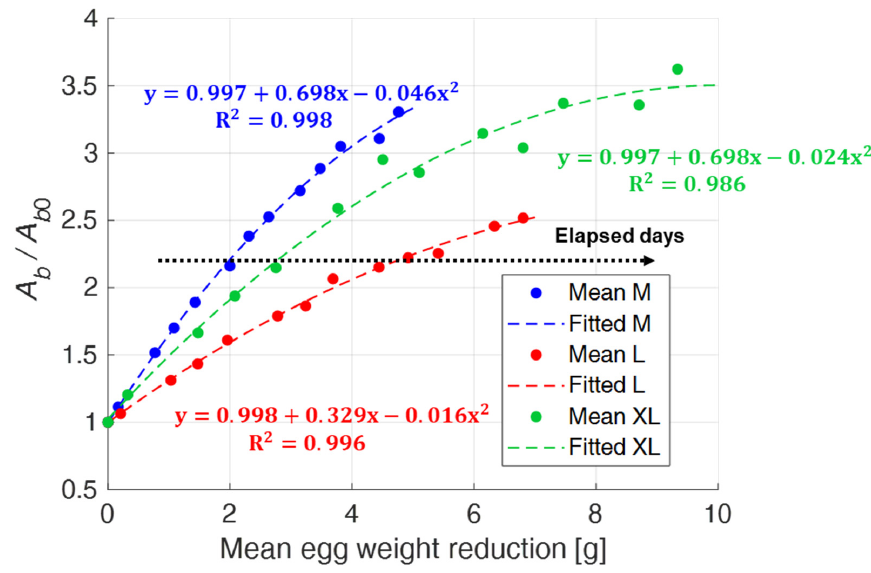
Figure 14. Second order polynomial regression between mean values of the normalized air chamber area and mean values of the egg weight reduction for different egg size categories (M, L,